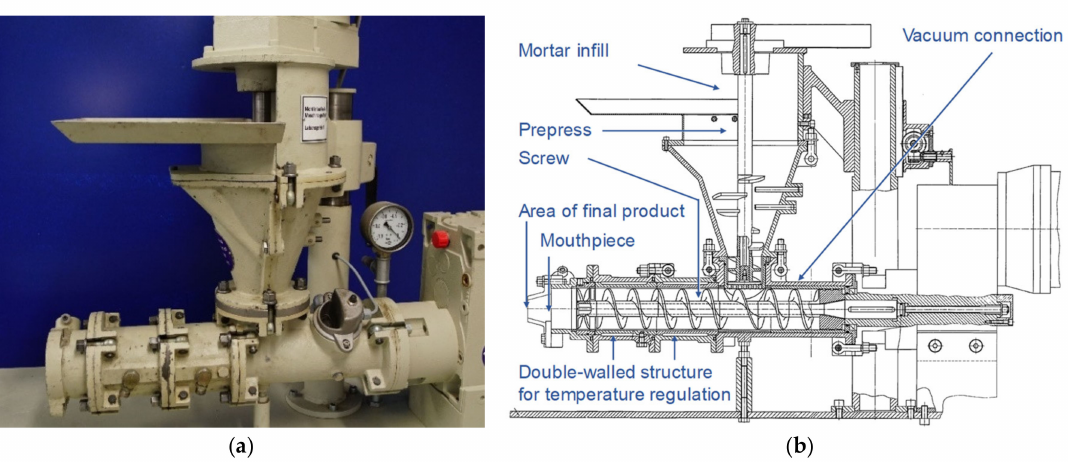
Figure 3. ( a ) Laboratory mortar extruder (LabMorTex) [21]; ( b ) schematic drawing of the LabMor- Tex [21].